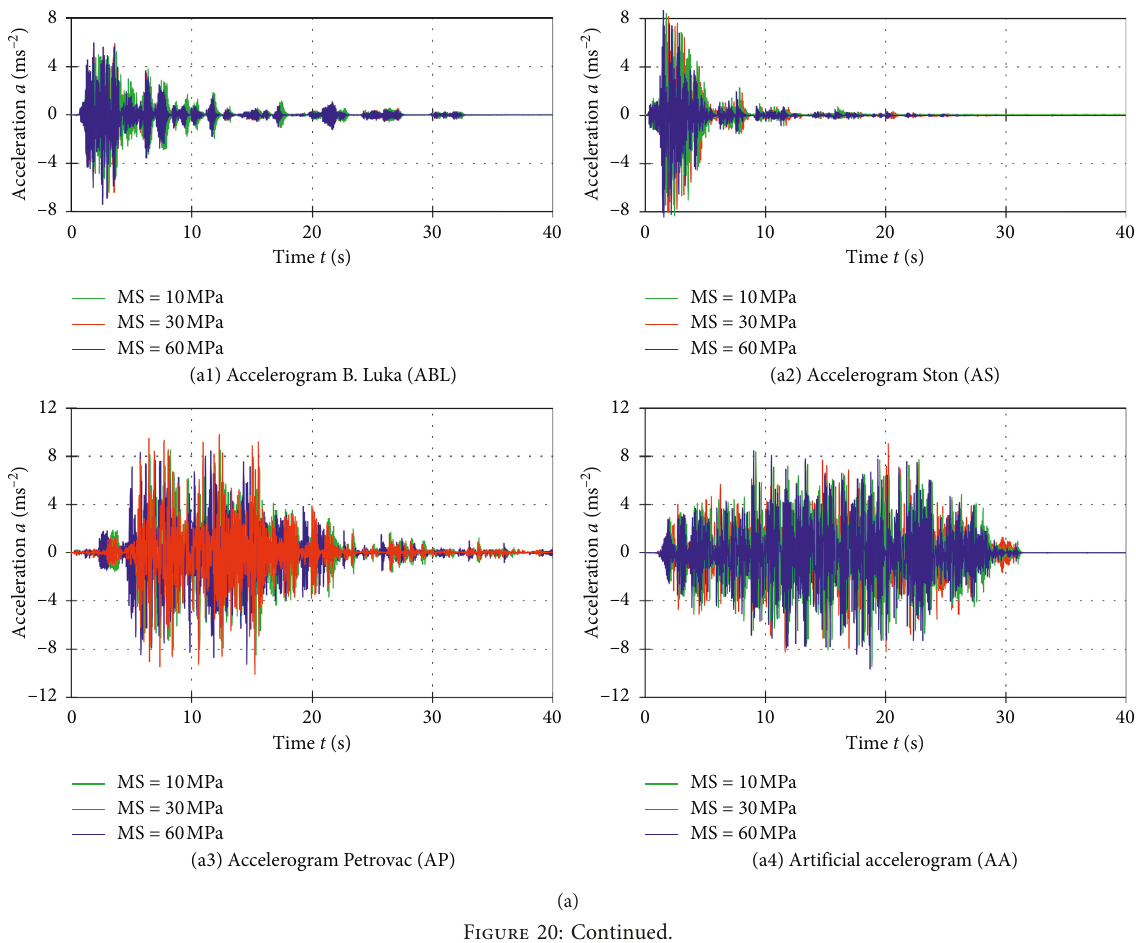
� 0.2g. (b) PGA � 2 . (a) PGA